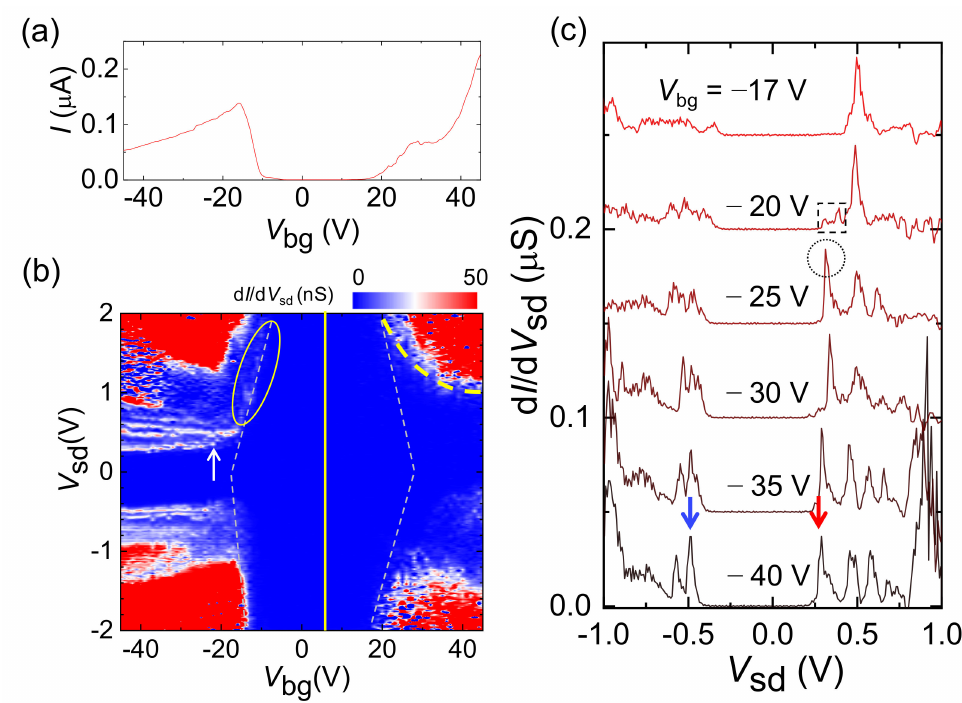
Figure 2. ( a ) I - V bg (transfer) curve for an sm -DWCNT ( L ≈ 6 µ m, D ≈ 1.7 nm) at V sd = 2 V and T = 10 K. ( b ) d I /d V sd map as a function of V sd and V bg of the sm -DWCT, where the dashed lines indicate the boundaries of the depletion region. The vertical line indicates the midgap location, E g /2. ( c ) d I /d V sd as a function of V sd for various V bg of the sm